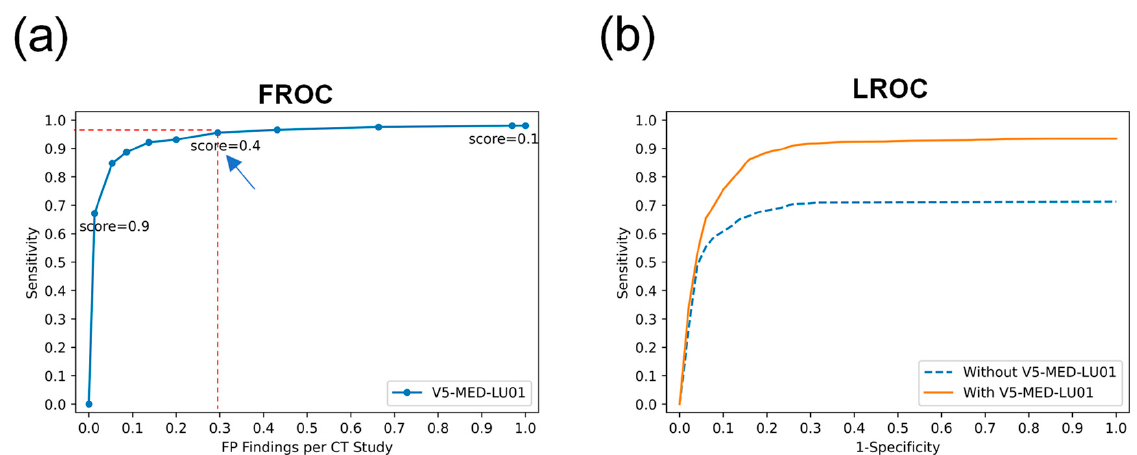
Figure 6. FROC and LROC curves to determine the superior sensitivity of AI-assisted CT screening. ( a ) The AI algorithm alone recognized the CT image stack of the patient, and the FROC curve was generated. ( b ) To generate the LROC curve, all doctors were instructed to mark and rate all suspicious nodules with or without AI assistance. The arrow points to the point where the AI score was greater than or equal to 0.4, while the false positive rate per CT study was 0.3, and the sensitivity reached 95.6%. FROC, free response operating characteristics; LROC, localization receiver operating characteristic; CT, computed tomography.